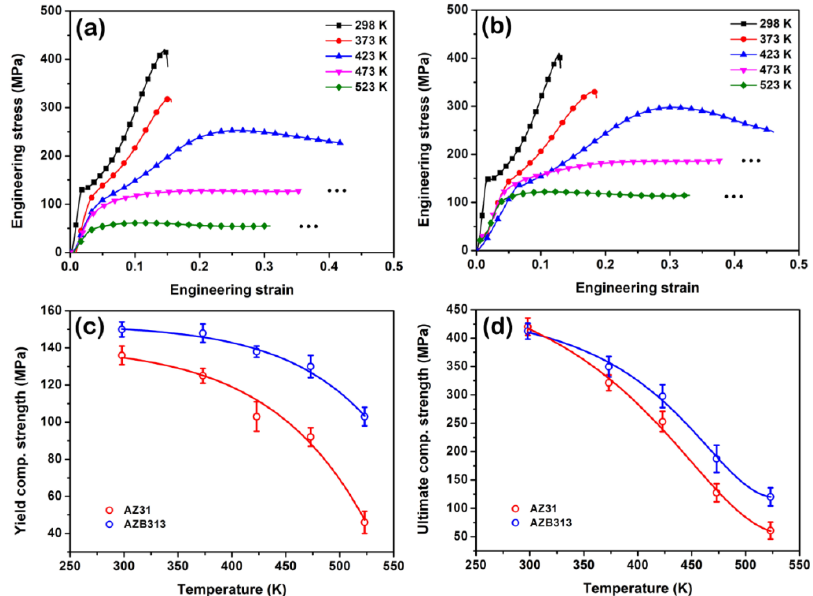
Figure 10. ( a , b ) Compressive engineering stress–strain curves of as-extruded AZ31 and AZB313 alloys, respectively, along ED at different temperatures; ( c , d ) comparison between compressive yield (and ultimate) strength values of as-extruded alloys, respectively.